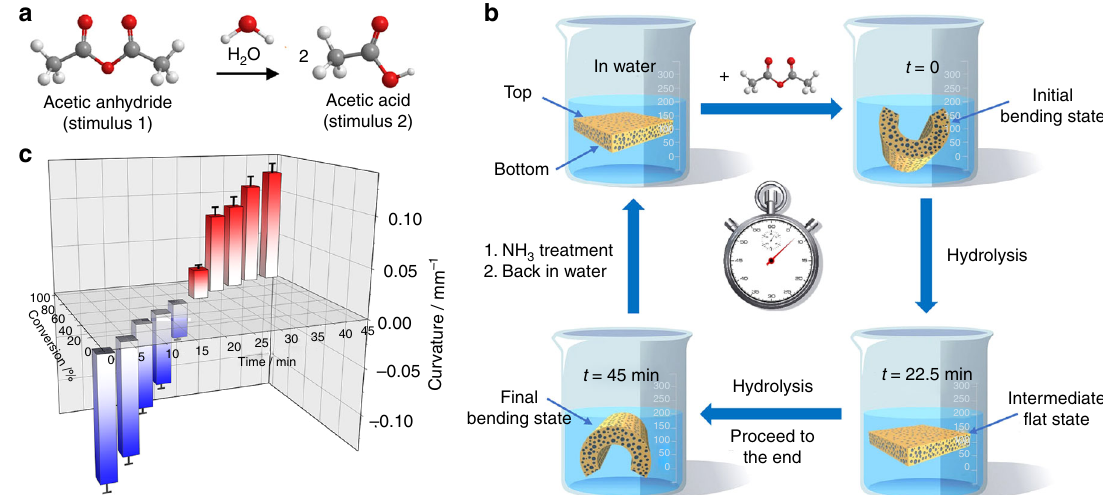
Fig. 6 The cascade actuation of tandem-gradient Ptriaz-TA membrane for monitoring a chemical reaction. a Ball-stick models represent of two stimuli (the origin reagent acetic anhydride as stimuli 1, and the acetic acid product as stimuli 2) driven for the cascade actuation. b Schematic illustration of a cascade motion of a membrane actuator along an entire process of hydrolysis chemical reaction of acetic anhydride in water. c 3D histogram by plotting the conversion of acetic anhydride against the corresponding curvature of a membrane stripe (1 mm × 25 mm × 120 µ m) in Supplementary Table 3 (the negative value of curvature means the membrane bending with bottom part outwards; positive value with bottom part